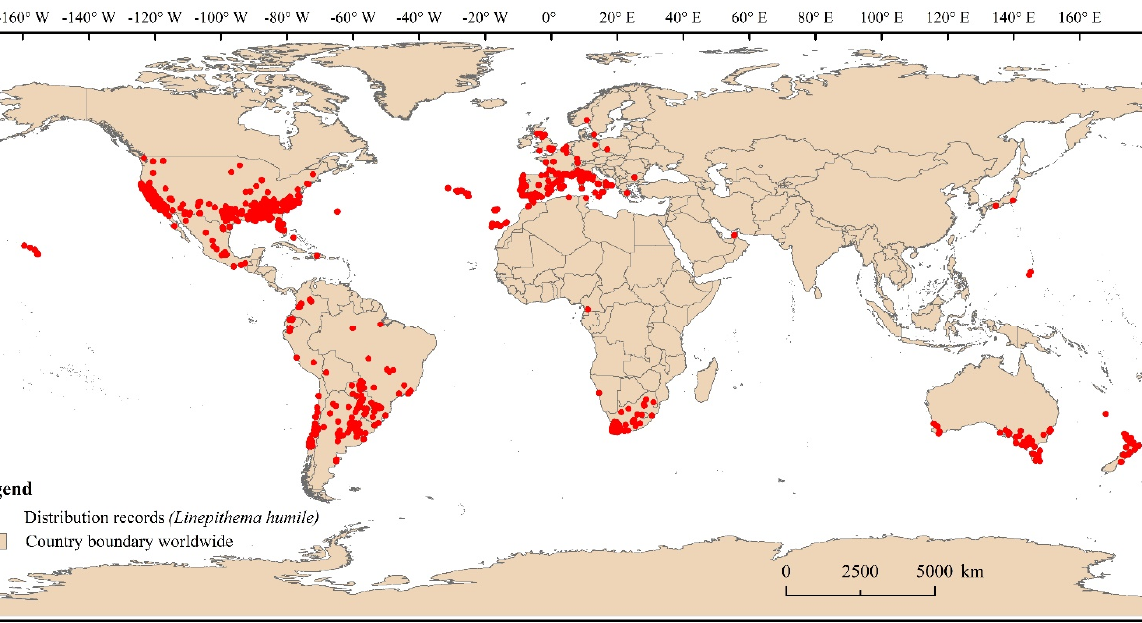
Table 1. Bioclimatic variables are related to the distribution of Linepithema humile.